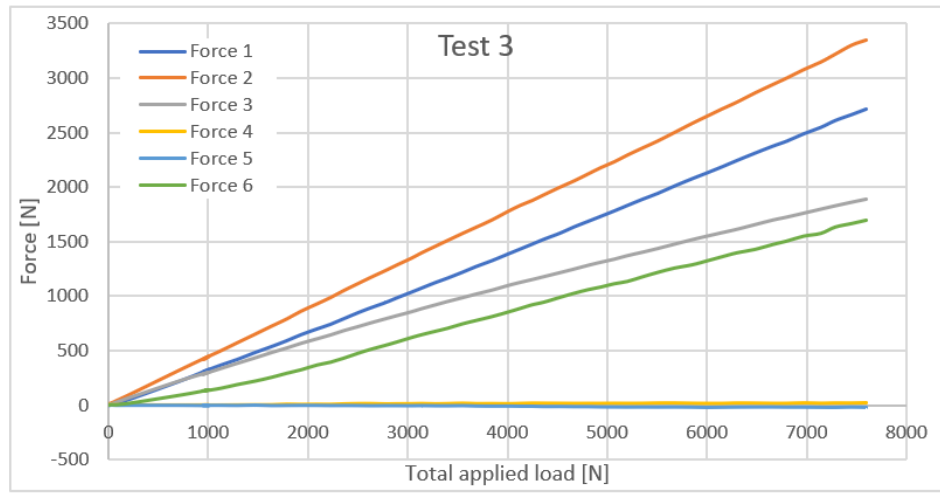
Figure 13. Total force redistribution into individual load cells during test three.